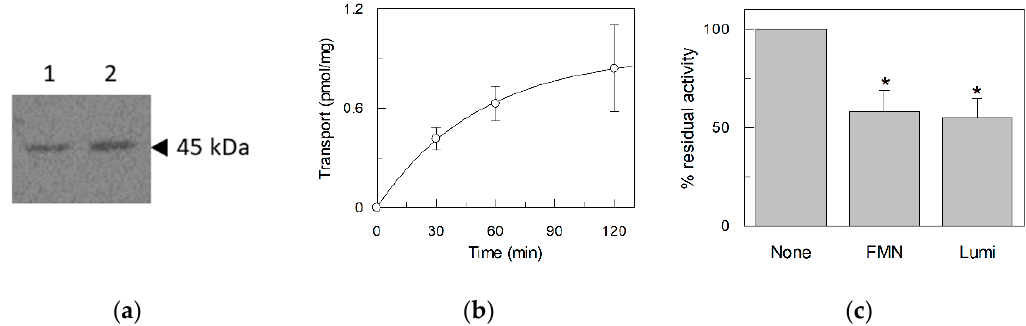
Figure 9. Native RFVT2 from primary human dermal fibroblasts. ( a ) Western Blot analysis of Native RFVT2. Protein extract from primary human dermal fibroblasts was separated by SDS–PAGE on 12% polyacrylamide gel and subjected to WB analysis using the anti-RFVT2 antibody whit a dilution of 1:2000. 50 µg and 60 µg of total protein extract from fibroblast were loaded in line 1 and 2 respectively; ( b ) time course of native RFVT2 extracted from primary human dermal fibroblasts and reconstituted in proteoliposomes. The transport measurement was started adding 0.1 µM [3H]riboflavin and stopped at the indicated times, as described in Materials and Methods; ( c ) Effect of FMN and lumiflavin on riboflavin uptake mediated by native RFVT2. The riboflavin transport was stopped after 120 min. The values are means ± SD from three experiments. Statistics was performed using Student ′ s t -test (* p < 0.05).